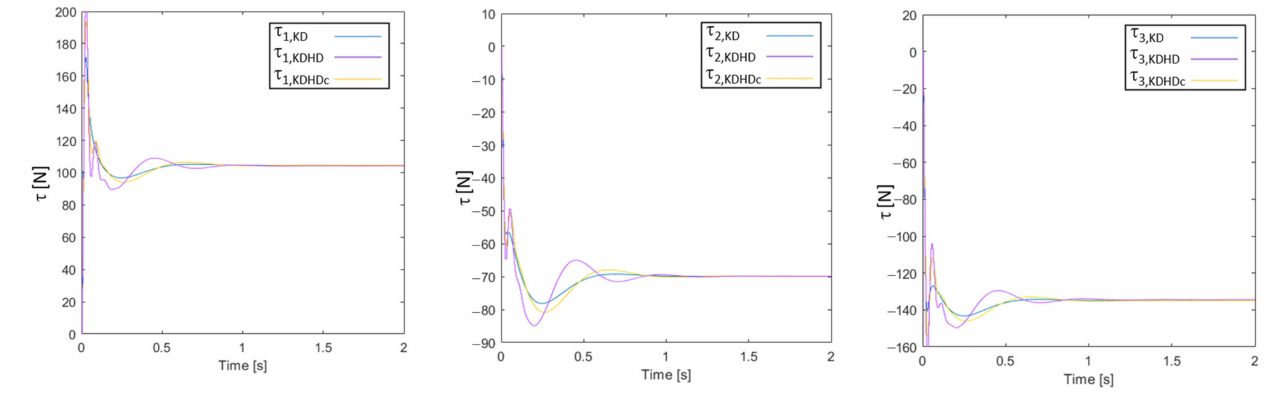
Figure 9. Case study B, KD-KDHD comparison number II, actuation